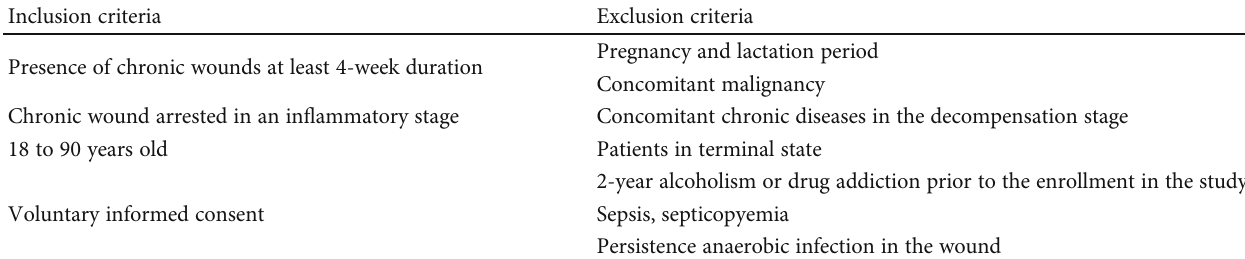
Table 1: Enrollment